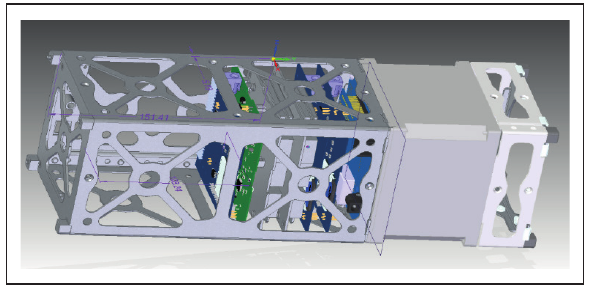
figure 1. Partial view of the Libertad-2 satellite structural